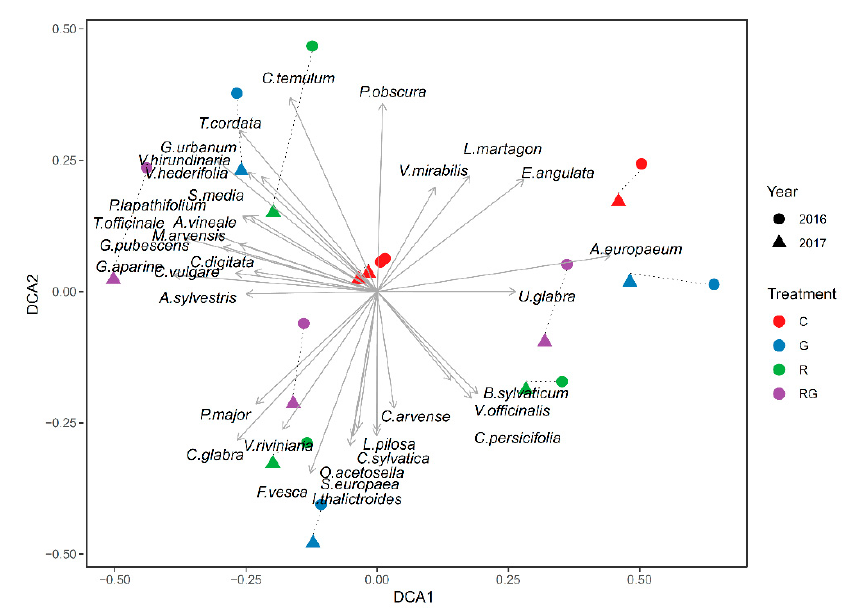
Figure 4. Detrended correspondence analysis (DCA) scatter plot of species covers summarized to plot level ( n = 24). Vectors of species were passively fitted for species significantly correlated with DCA1 and DCA2 axes ( p < 0.02; Pearson’s r > 0.300). Treatments: C—control, G—grazing, R—mechanical removal of brush, RG—grazing followed by mechanical removal of brush, year 2016—before the treatment, year 2017—after treatment.